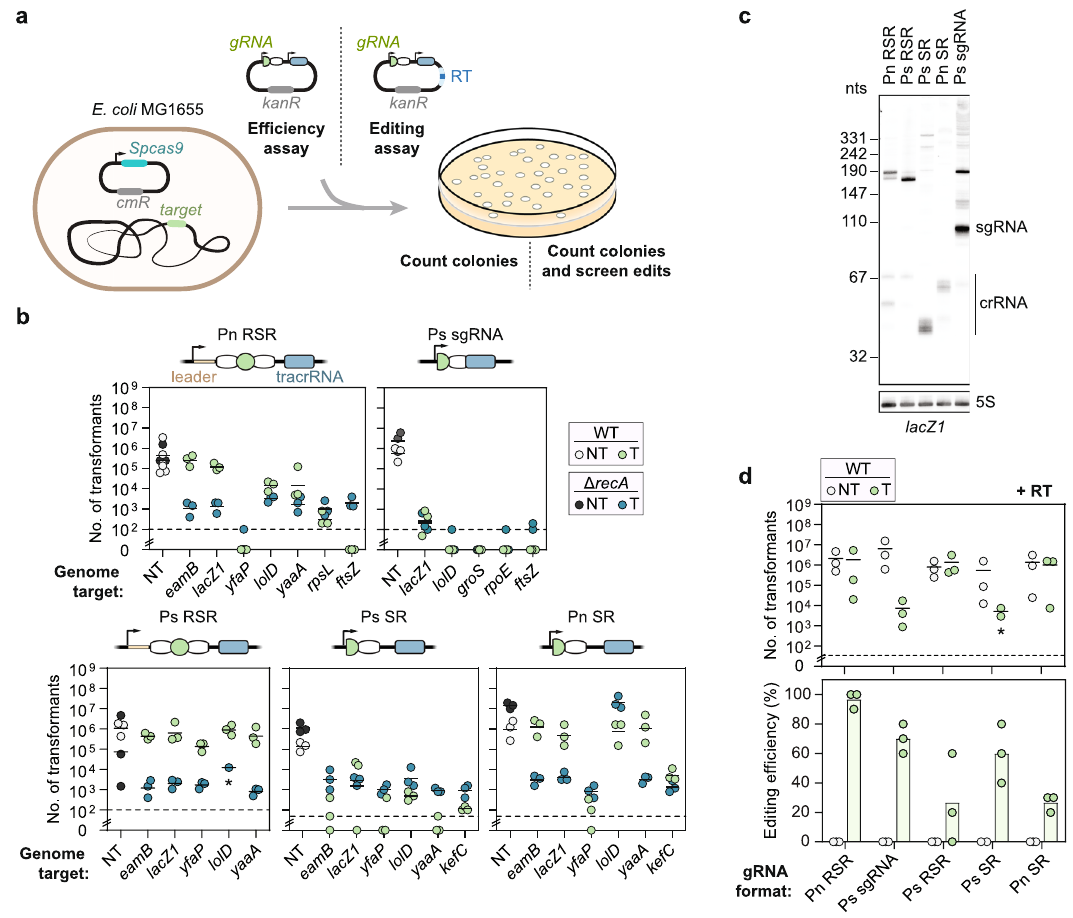
Fig. 1 | The outcome of chromosomal targeting in E. coli depends on gRNA format and abundance. a Schematic of the experimental setup for chromosomal targetingandediting. b Genometargetingassayin E.coli and E.coli Δ recA . c Northern blot analysis of whole RNA isolated from E. coli Δ lacI-Z with pCas9 and pgRNA. A lacZ1 spacerspeci fi cprobewasusedtoprobetheabundanceofeachRNAproduct.A 5S probe was used as a control on the same gel and shown below the lacZ1 probed gel. The approximate size of an sgRNA is indicated to the left of the Northern blot and the approximate size of mature crRNAs are indicated with a line. d Genome editing assay in E. coli targeting lacZ1 to introduce AvrII restriction enzyme recog- nition site as a silent mutation. Individual dots for the transformations indicate a single biological replicate. * indicates that the transformants resulted in a lawn or